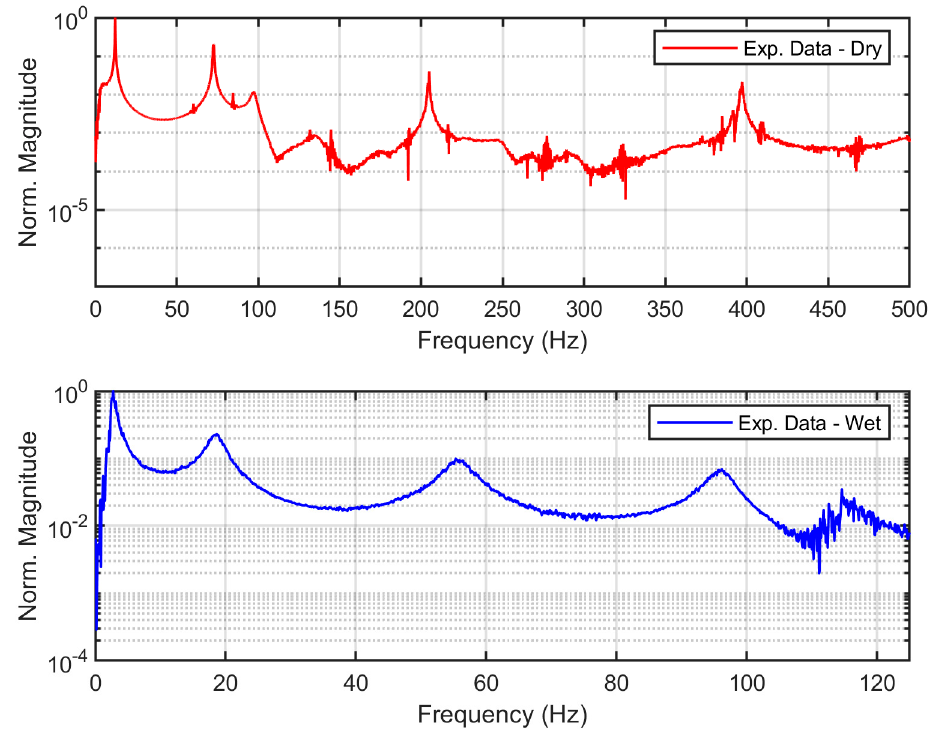
Figure 17. FRF of the beam in dry and wet conditions.